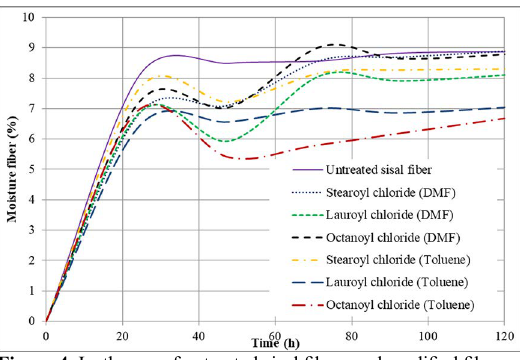
Figure 4. Isotherms of untreated sisal fibres and modified = Initial degradation temperature) and DTG (T i